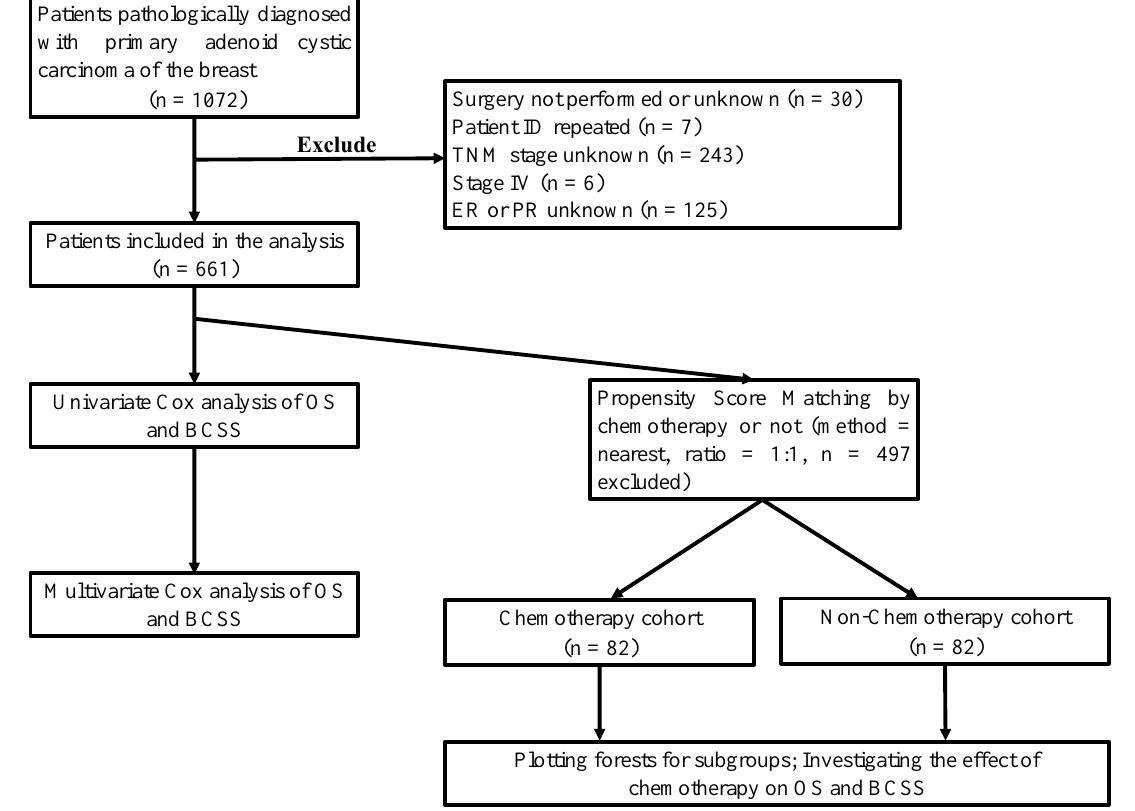
Figure 1. Recruitment of participants.